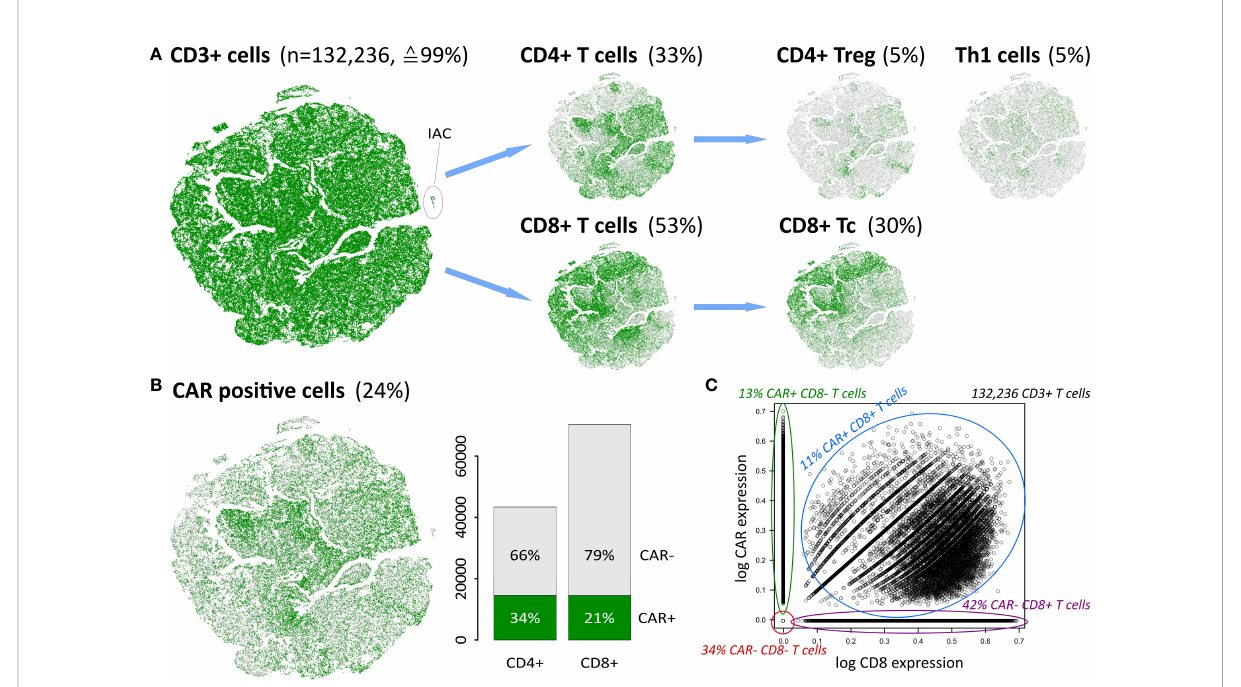
FIGURE 2 Cellular identity decomposition using consensus markers: (A) Assignment of T cell subpopulations and t-SNE projection. Percentages refer to total number of cells in the data. (B) CAR positive cells decompose into CAR+ CD4 and CD8 cells, respectively. A small population of ICANS- associated cells (IAC) with myeloid characteristics (14) segregate in a separate cluster as indicated. (C) CAR expression as a function of CD8 expression in CD3+ T cells reveals that double positive cells express both markers, while single positive and negative populations distribute along the y- and x-axis, respectively. Proportions given in the fi gure relate to the total number of 132,236 CD3+ T cells in the data